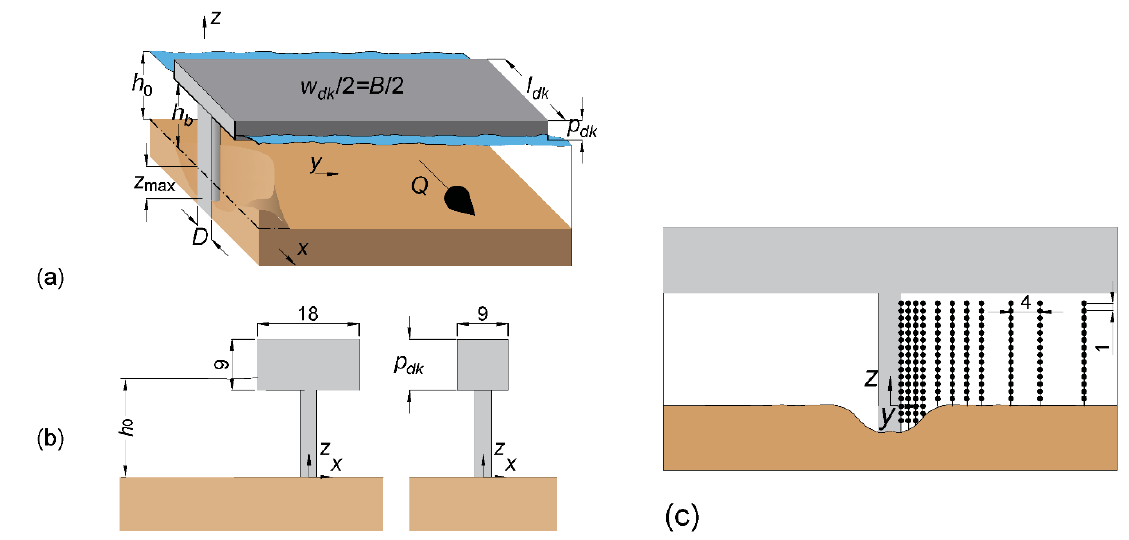
Figure 1. Diagram sketch and notation. ( a ) Perspective view of tested conditions, scour definition, and deck view; ( b ) longitudinal view with dimension of the two tested decks (in cm); ( c ) locations of sampled velocities at section x = 0 underneath the deck (in cm).